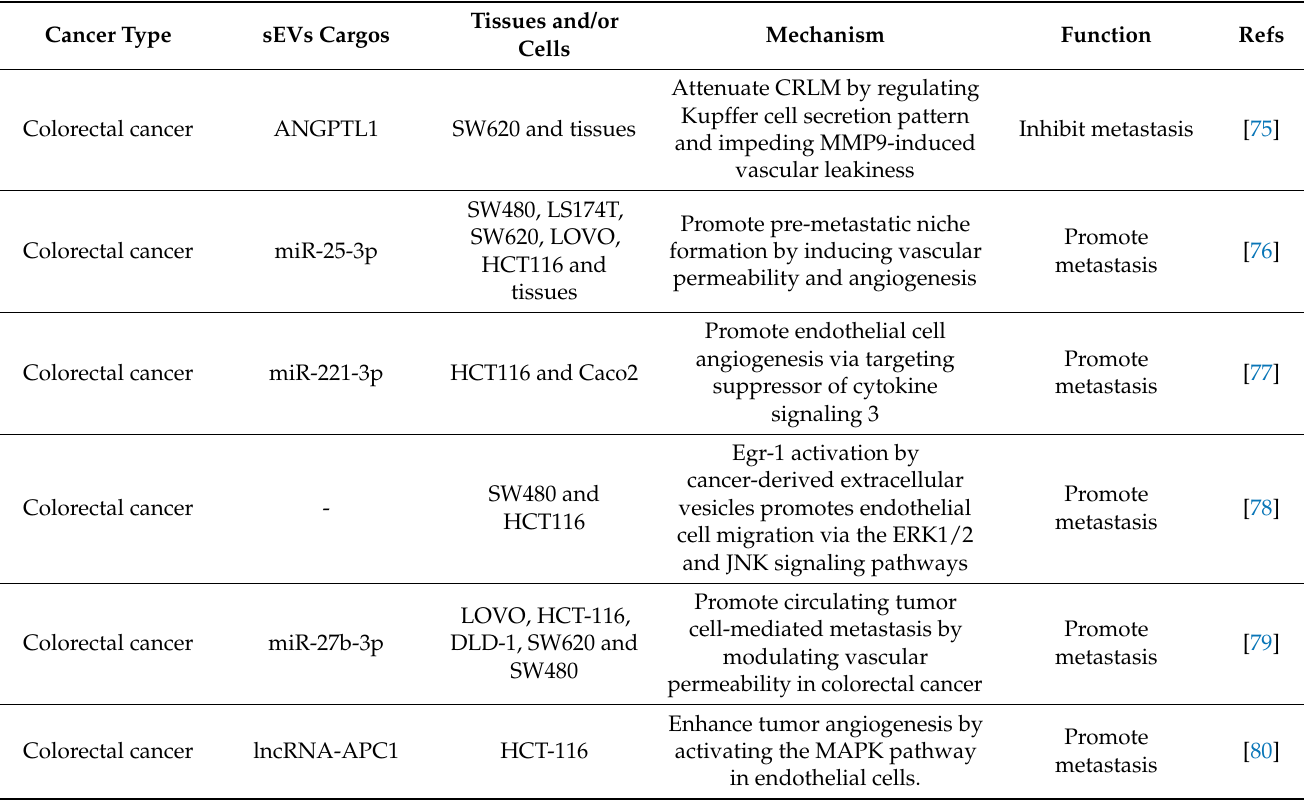
Table 4. sEVs increase vascular leakage and angiogenesis to promote CRC